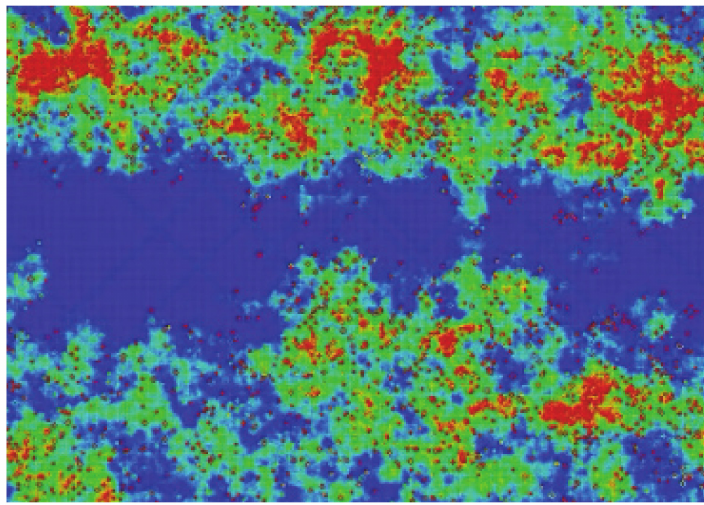
Figure 12. (Color online) Example of the mixing interaction of the two separated communities (up and down). The color scale corresponds to the number of timesteps that the cells have been active. See Video 3 in the supplementary